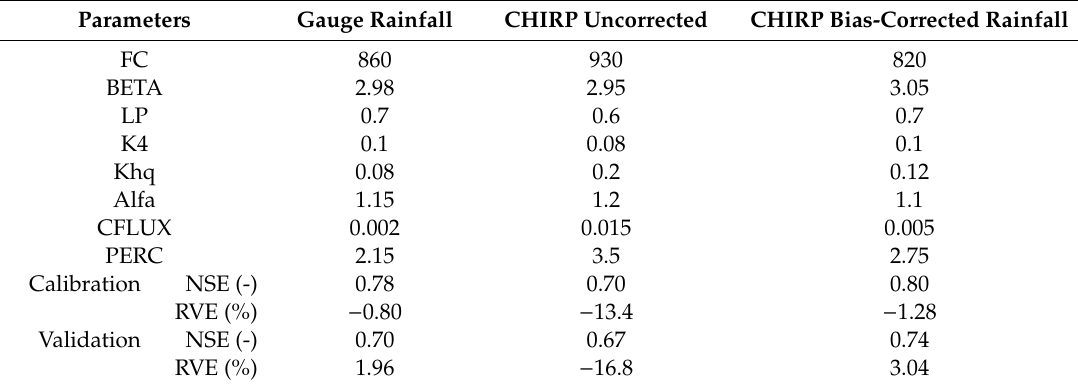
Table 7. Calibrated model parameter values and their performance for gauged, uncorrected, and bias-corrected CHIRP rainfall data for Katar